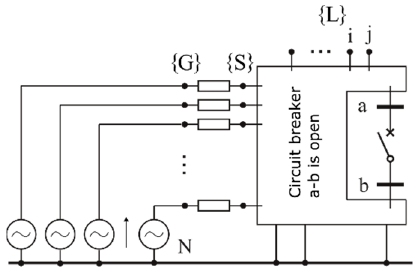
Figure 2. Creating a mathematical model of switch-on